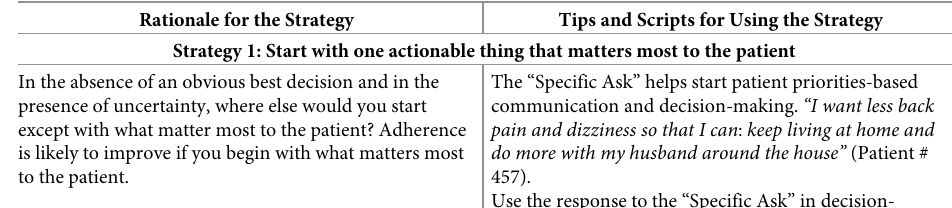
Table 2. Strategies for implementing patient priorities-aligned